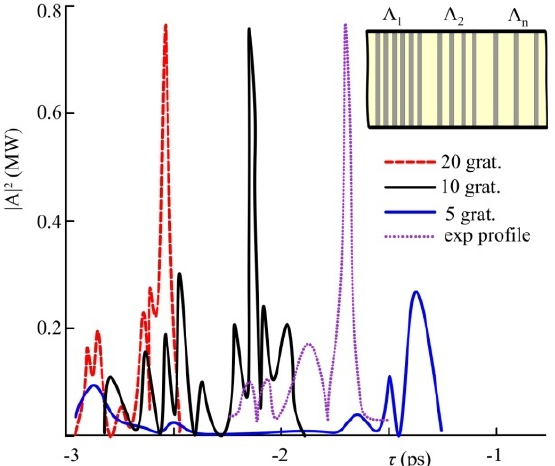
Figure 2. Temporal compression of frequency-modulated pulse in the passive fiber with inscribed FBGs providing the dispersion decreasing distribution along the fiber length. The initial pulse power is 7700 W, the duration is 10 ps, and the fiber length is 20 cm.